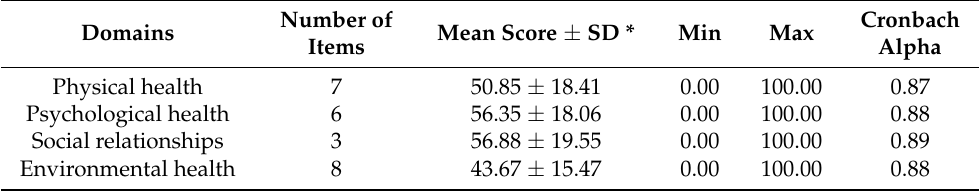
Table 1. Participants’ overall scores on WHOQOL-BREF domains.